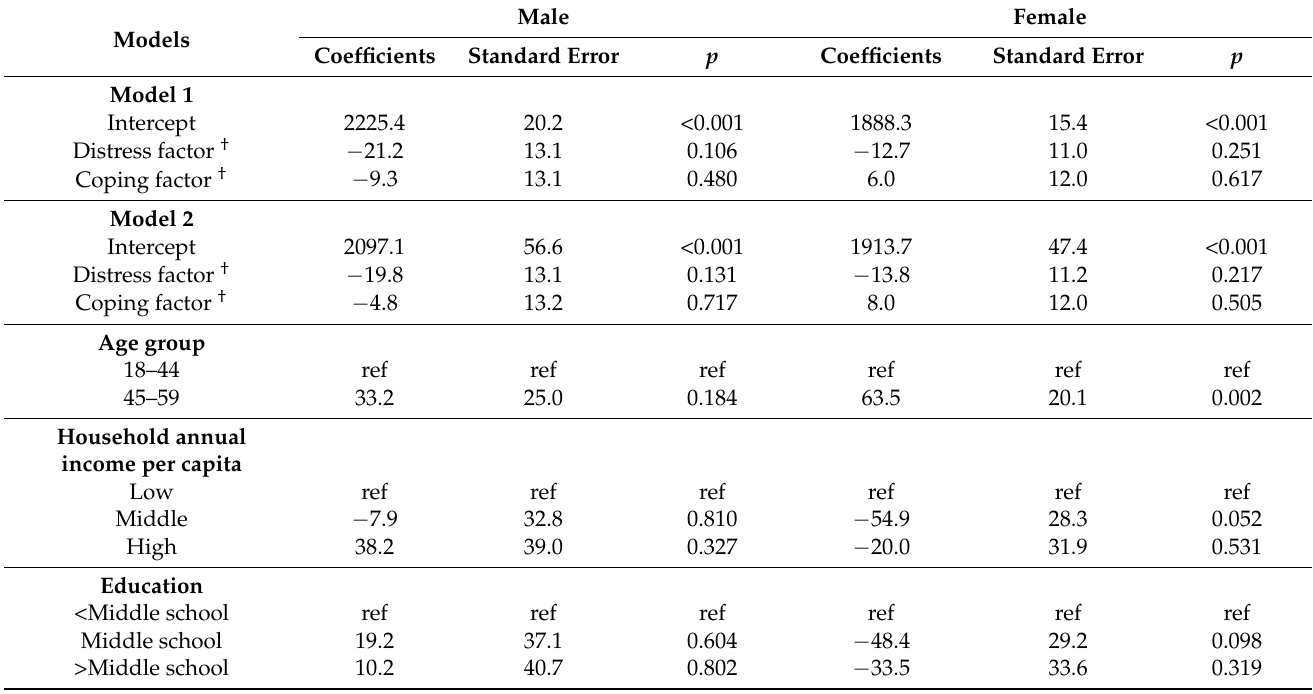
Table 2. The effects of distress and coping factors on energy intake by gender.